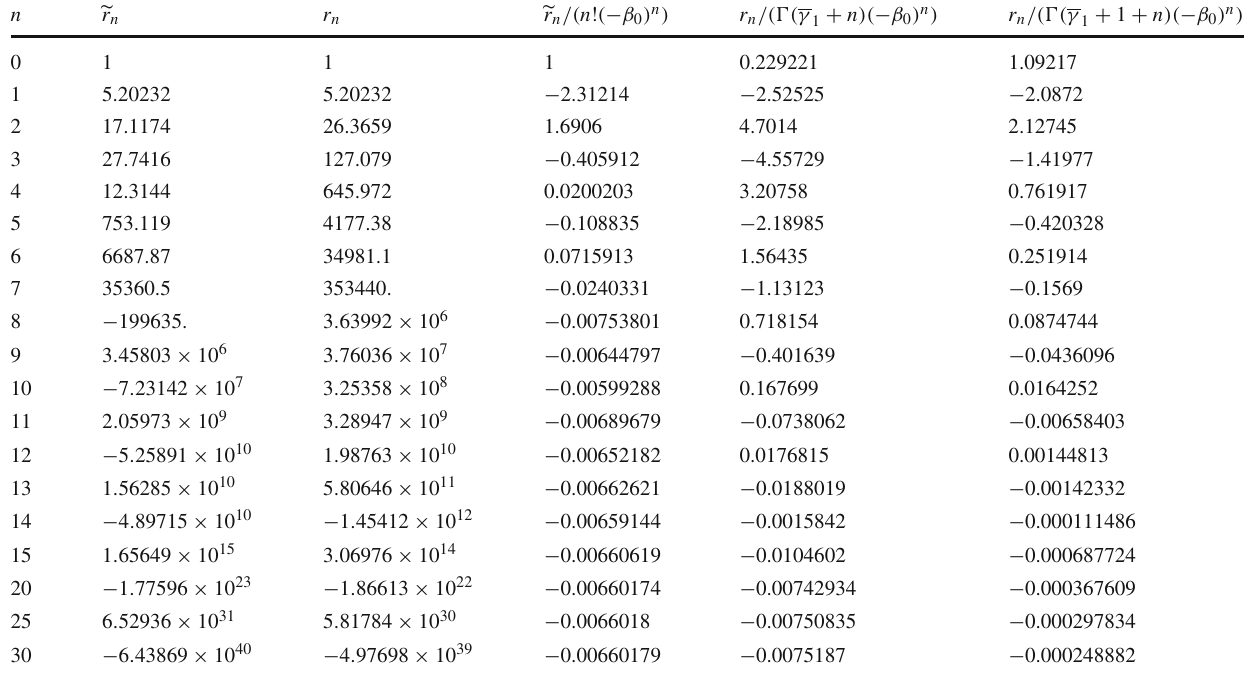
function extension was used. The values of the first four coefficients ( n = 0 , 1 , 2 , 3) coincide with the exactly known values. See the text